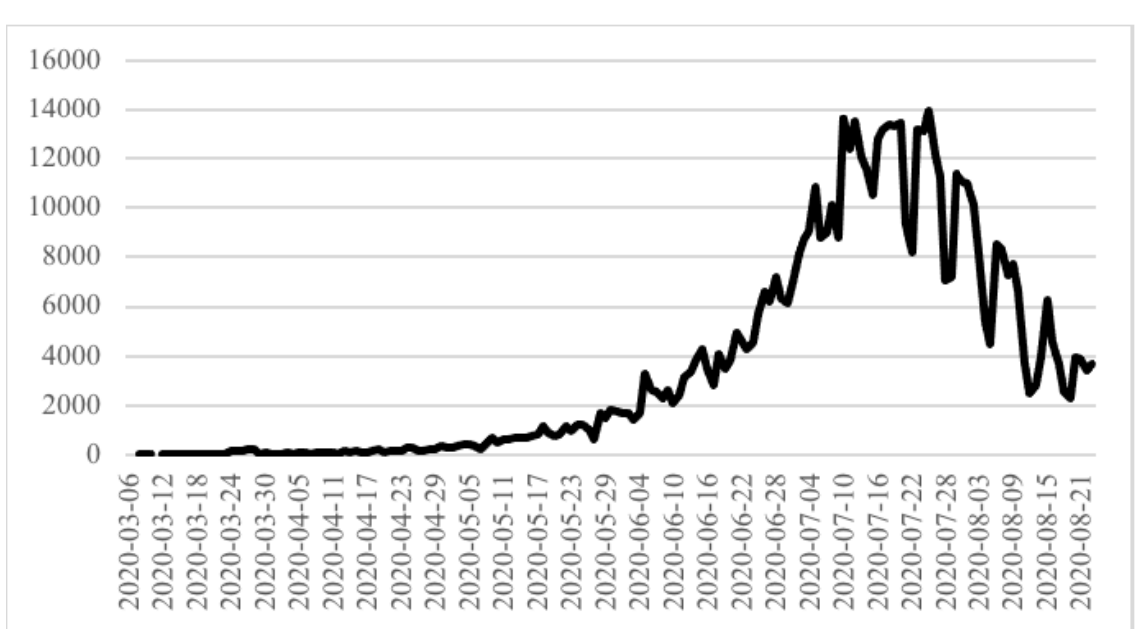
Figure 2. Flattening the COVID-19 curve in South Africa: 6 March – 23 August 2020. Source: Naudé and Cameron (2020), see Note 15.